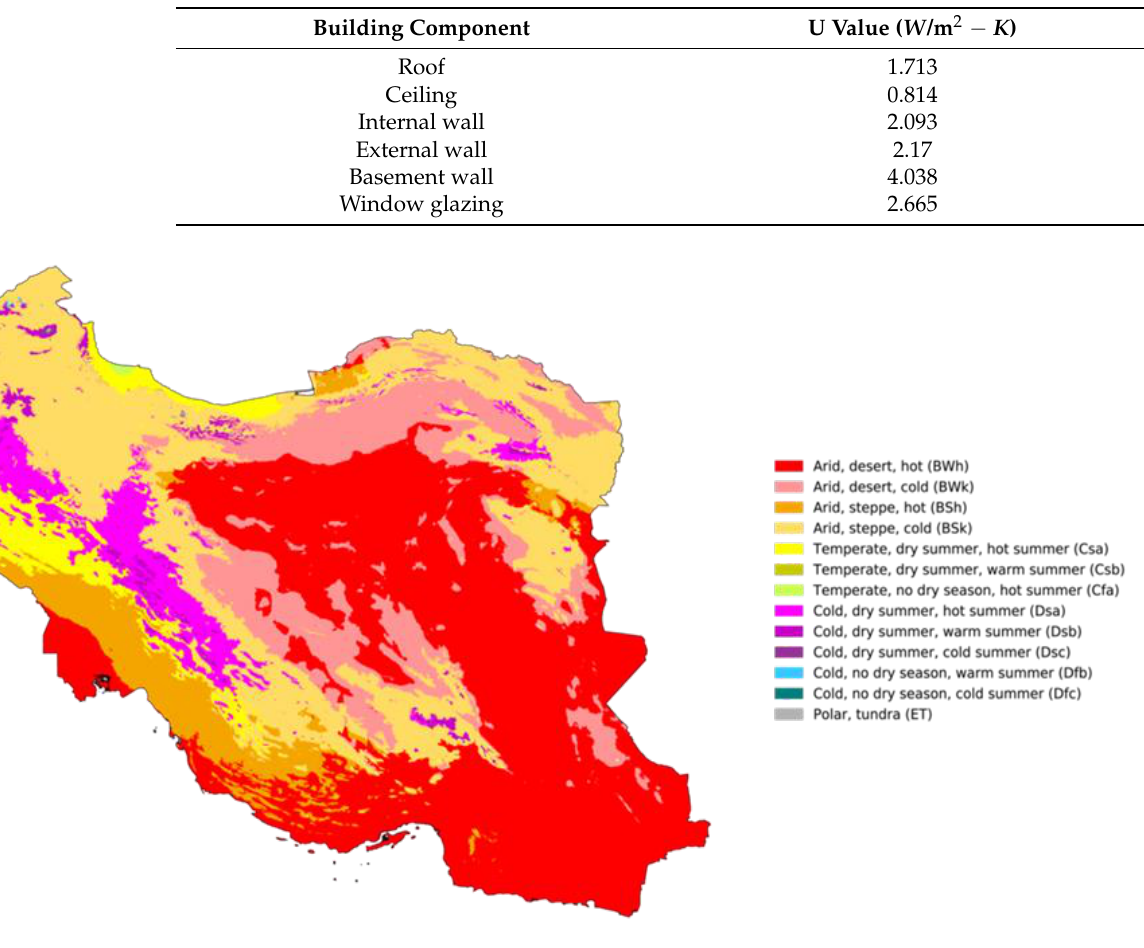
Figure 4. Map of Iran with details of the geographic location and the climate zone classification of all meteorological stations according to the Köppen climate classification.